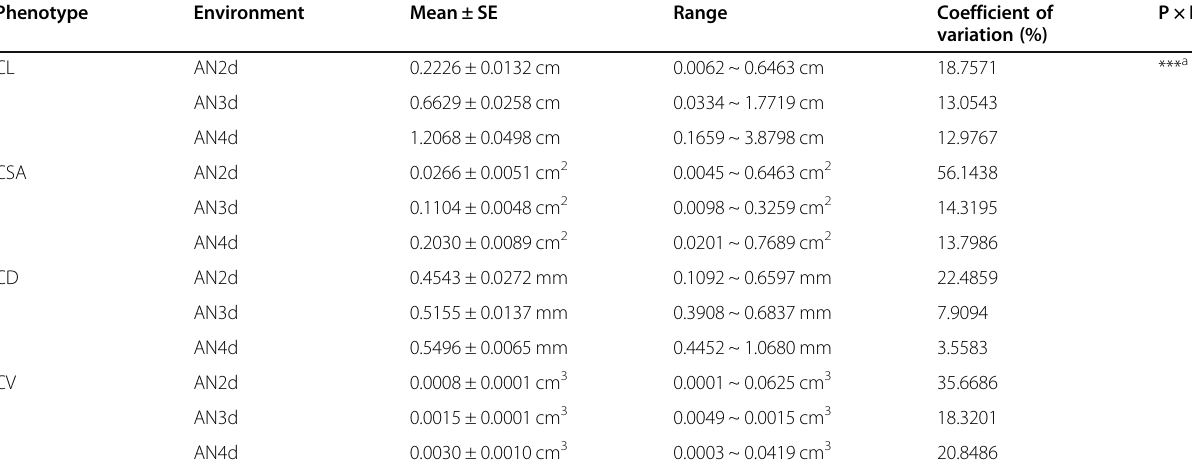
Table 1 Phenotypic variation of rice coleoptile during submergence